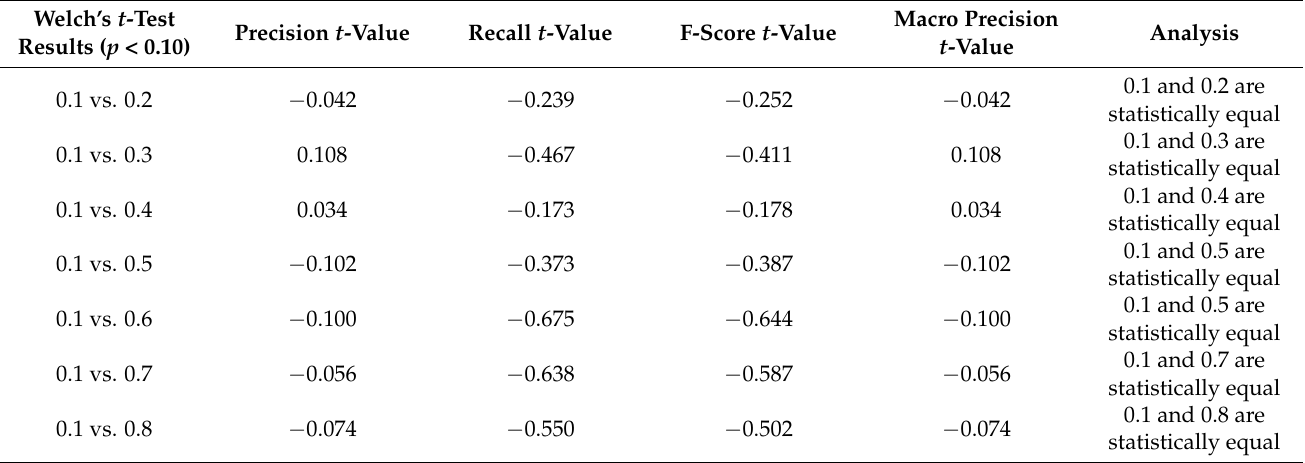
Table 14. Welch’s t -test results: UWF-ZeekData22: privilege escalation—random undersampling before